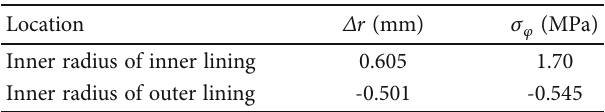
Figure 8: Radial deformation and circumferential stress of outer lining. Table 2: Numerical analysis results.